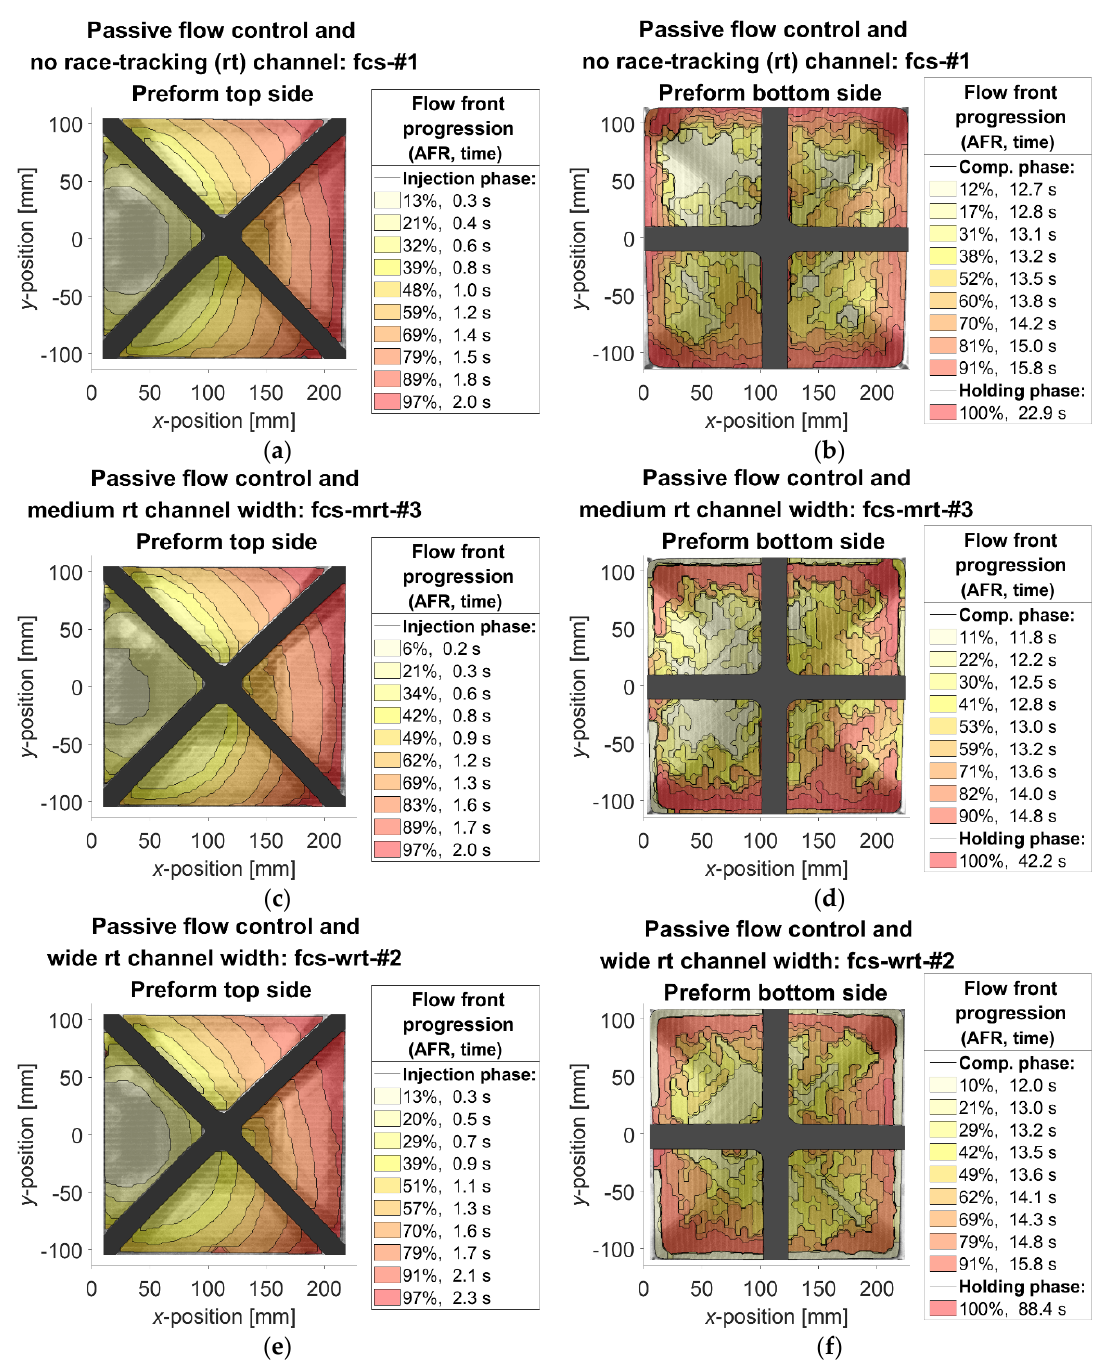
Figure 11. Flow front progression of FS-CRTM experiments of the flow control study: ( a , b ) no race-tracking (rt) channel— fcs-#1; ( c , d ) medium race-tracking channel width—fcs-mrt-#3; ( e , f ) wide race-tracking channel width—fcs-wrt-#2 (AFR = area filling ratio).